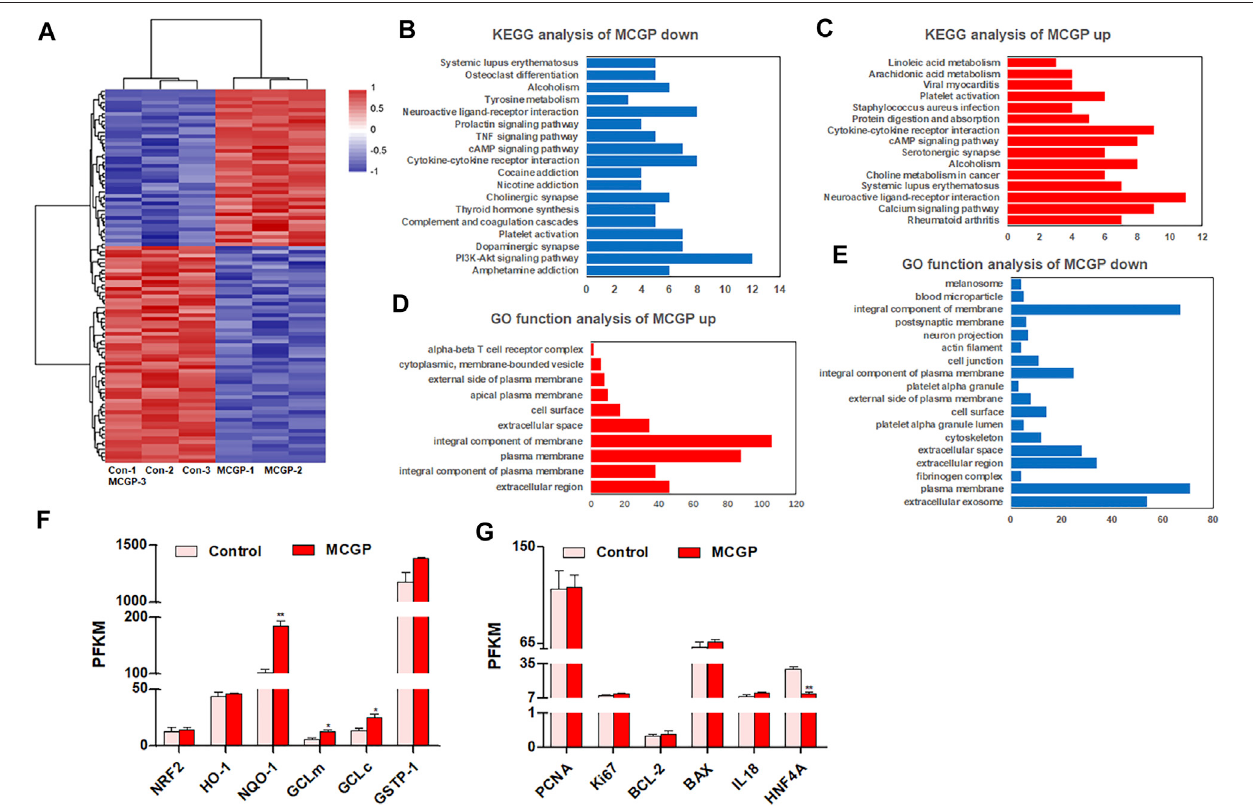
FIGURE 3 | RNA-seq of control or MCGP-treated HepG2 cells. (A) The expression heat map of differentially expressed genes in MCGP-treated HepG2 cells. (B) KEGG pathway enrichment of MCGP upregulated genes. (C) KEGG pathway enrichment of MCGP downregulated genes. (D) GO function analysis of MCGP upregulated genes. (E) GO function analysis of MCGP downregulated genes. (F,G) The PKFM value of NFR2 signaling pathway components (F) and liver regeneration related genes of MCGP administration in HepG2 cells. * p < 0.05, ** p < 0.01 vs